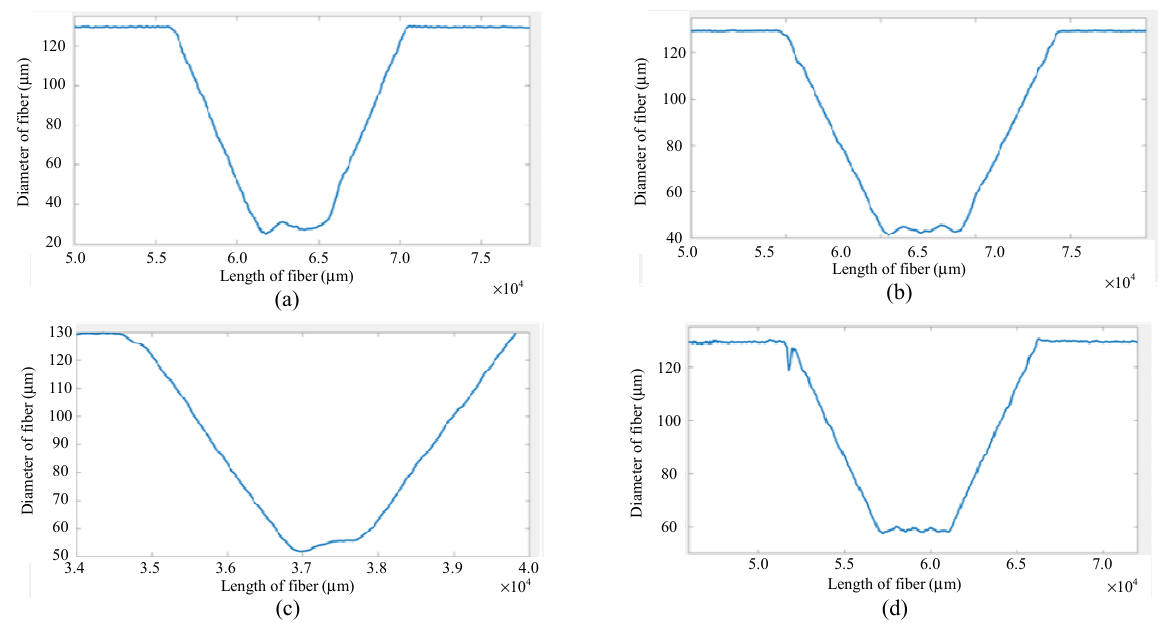
Fig. 5 Diameter analysis of fabricated tapered fiber structures plotted through MATLAB.